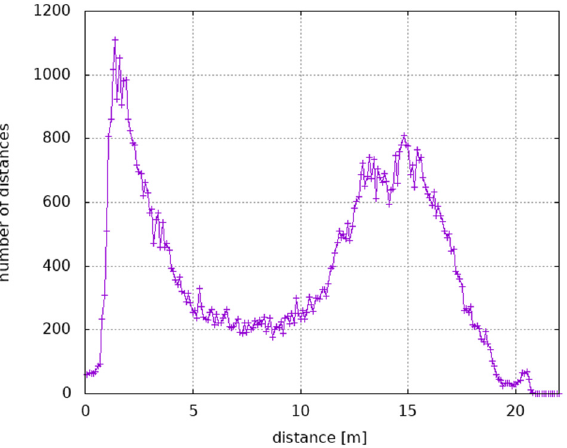
Figure 6. Statistics of distances between two consecutive return pulses of each laser pulse for the sample area shown in Figure 4.